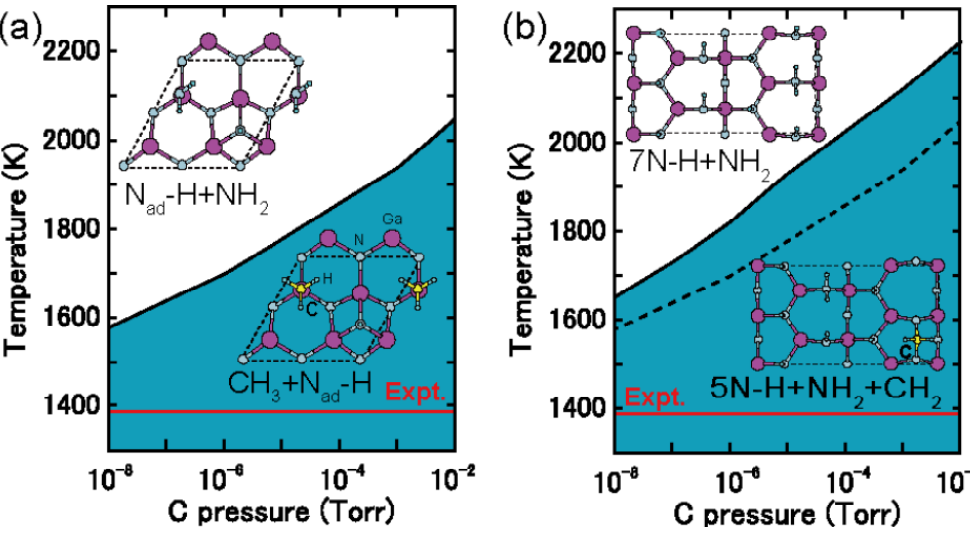
Figure 38. Calculated surface phase diagrams for C-incorporated ( a ) GaN(0001) and ( b ) GaN (cid:4666)11(cid:3364)01(cid:4667) surfaces at the N-rich limit ( μ = − 1.24 eV) as a function of temperatures Ga and C BEP. The carbon incorporated surfaces are stabilized in the shaded regions. Schematic views of surface structures are also presented. The growth temperature from [139,140] are shown by red lines. For comparison, the dashed line in ( b ) denotes the phase boundary between carbon free and incorporated surfaces on the GaN(0001)